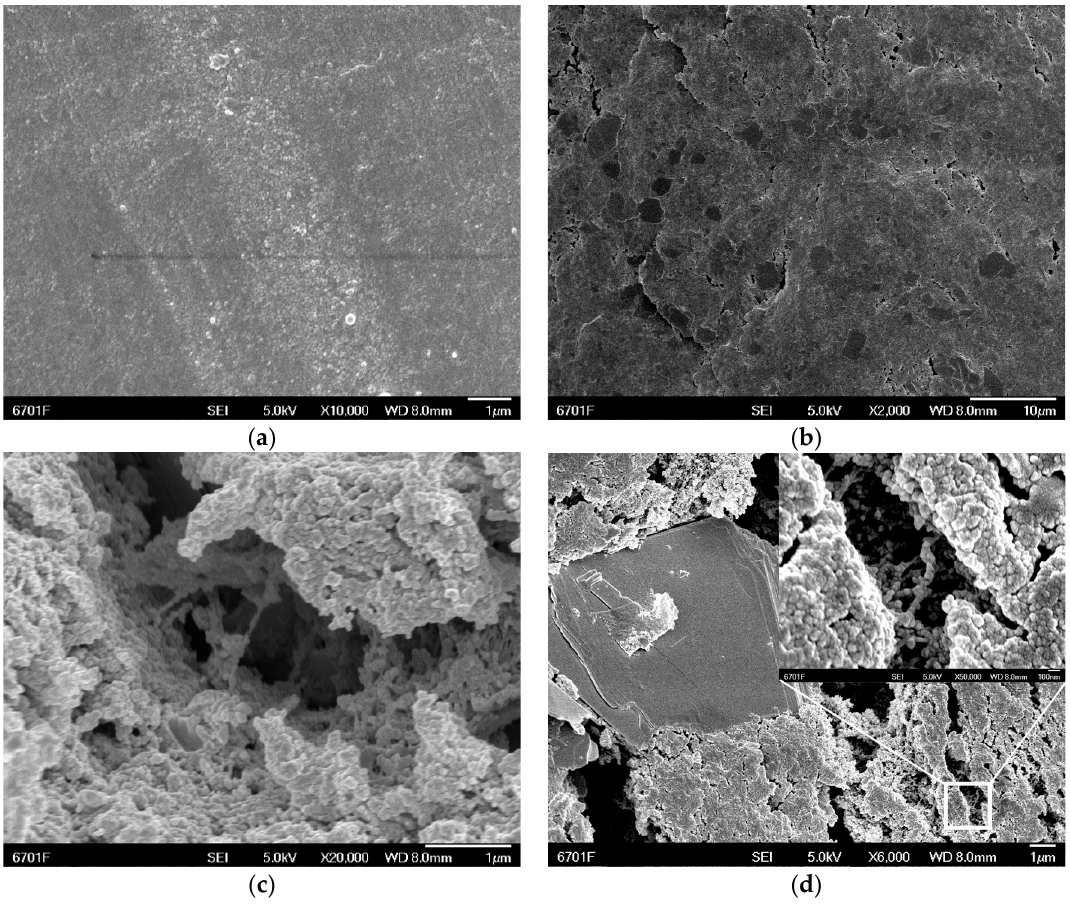
Figure 3. Surface topography of additives and composites. ( a ) Epoxy resin (EP), ( b ) EP+ MoS 2 , ( c ) EP+ H-CNTs, and ( d ) EP+ MoS 2 + H-CNTs.